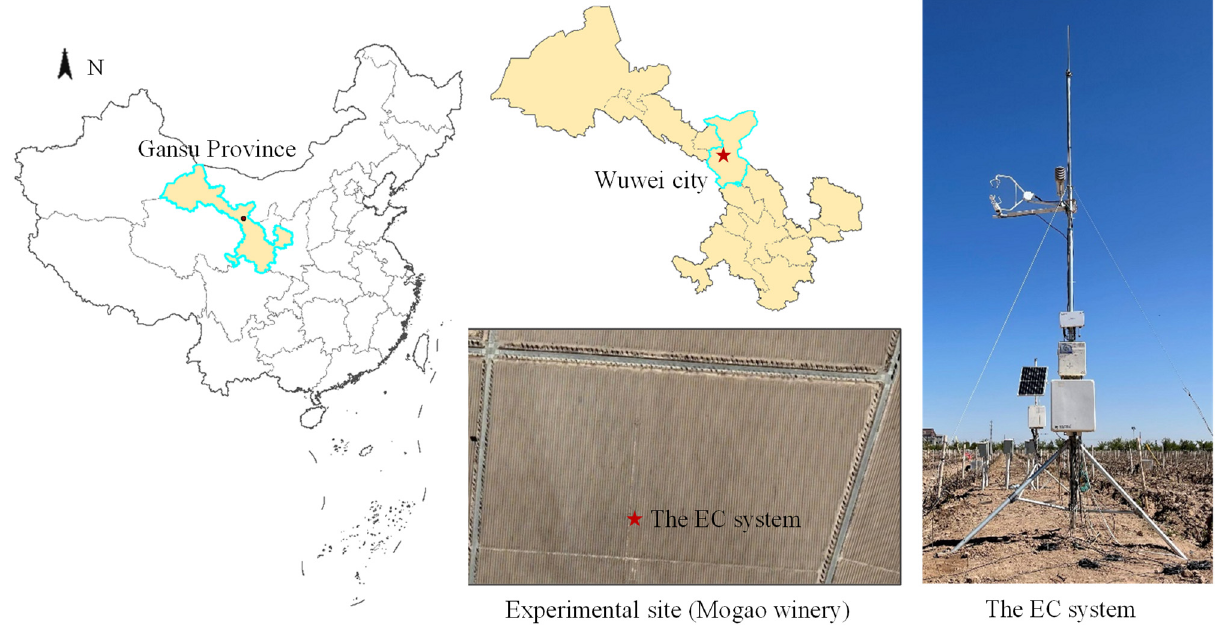
Figure 1. Location of the experimental site.